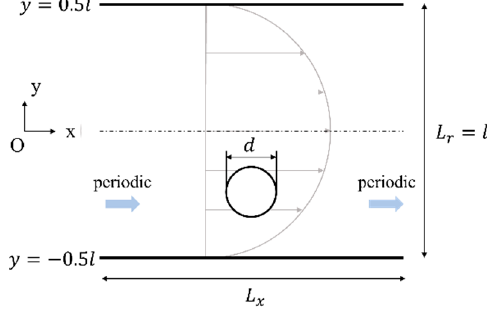
Figure 4. Computational model of straight